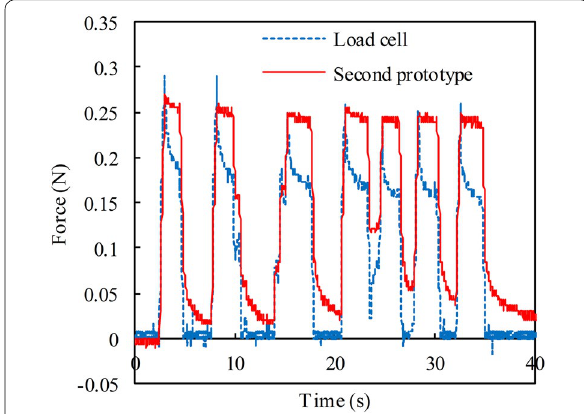
Fig. 14 Comparison of two forces measured by second prototype sensor and load cell when a random force was applied ( T > T g , h T 0.05 mm). Similarly to Fig. 13, we calculated the applied =